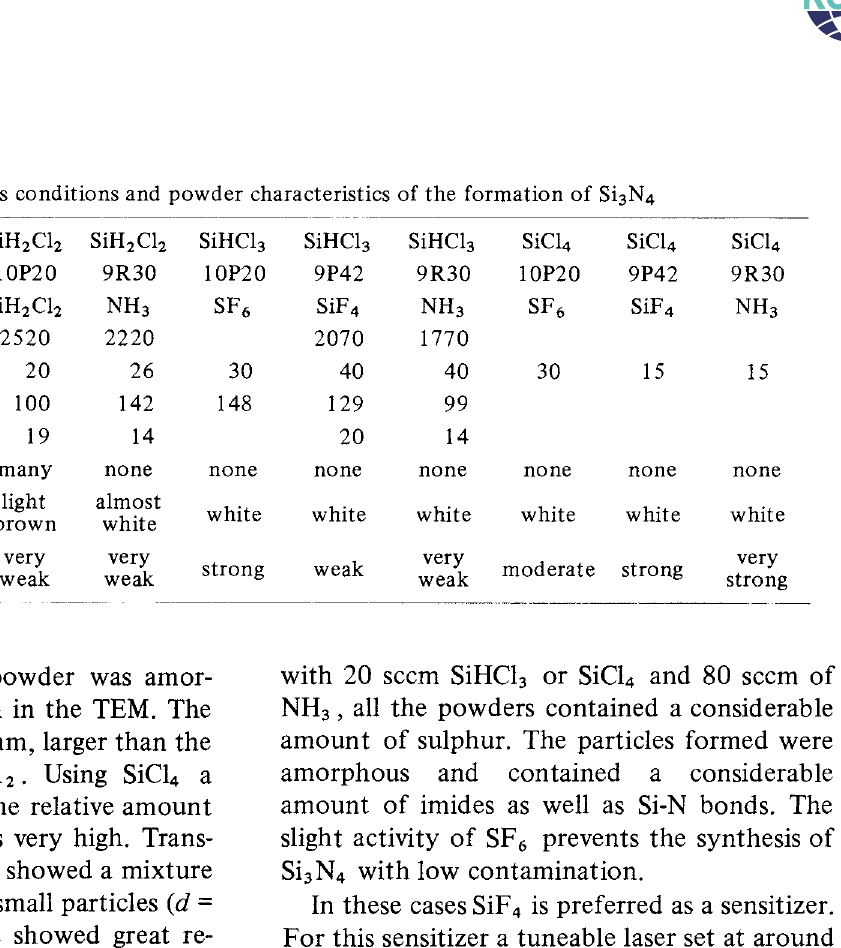
Table 1 Process conditions and powder characteristics of the formation of Si3N 4 ------ -~---------·-------- Reactant SiH2Cl2 SiH2Cl2 Laser